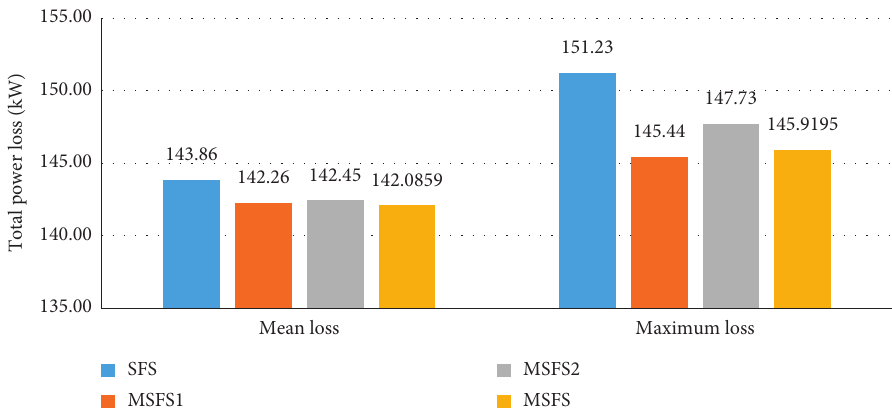
Figure 4: Mean and maximum power loss of 50 trial runs obtained by SFS methods for case 1 of the 33-bus system.